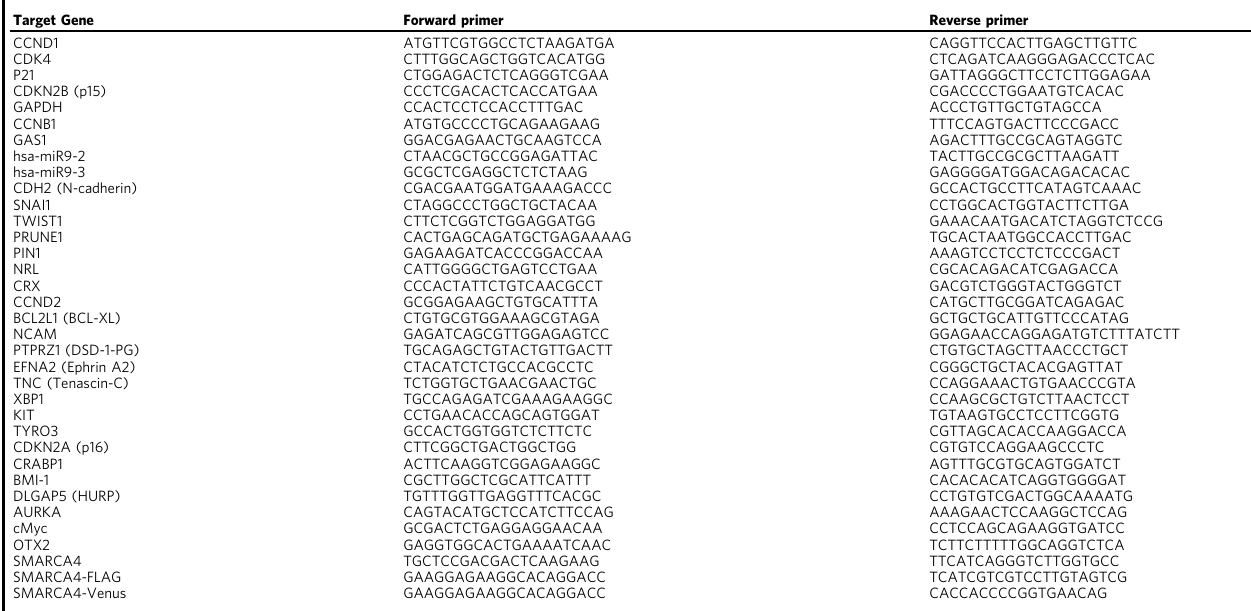
Fig. 6 Mutant SMARCA4 represses wild-type SMARCA4 functions. a mRNA expression analysis of human cerebellar progenitors (AF22 cells) 72 h